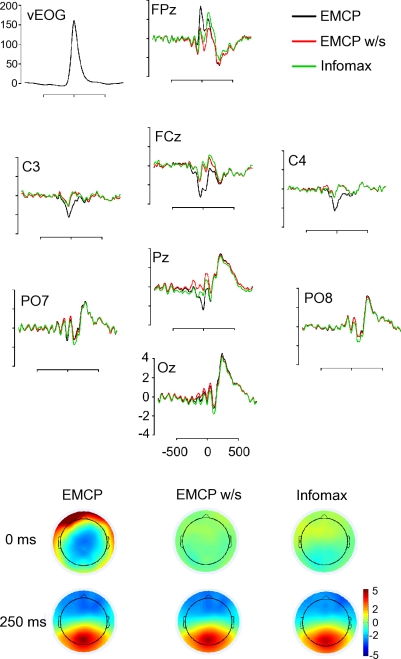
Blink-time locked grand averages of corrected data.Upper figure: Grand averages of activation (µV) of data corrected by Infomax, EMCPs and EMCP w/s. Lower figure: Topographic maps (spherical spline interpolation) of the activation subsequent correction at the time point of maximum blink excursion (0 ms) and 250 ms after it. Infomax = extended infomax. vEOG = (|SO2|-|IO2|)/2